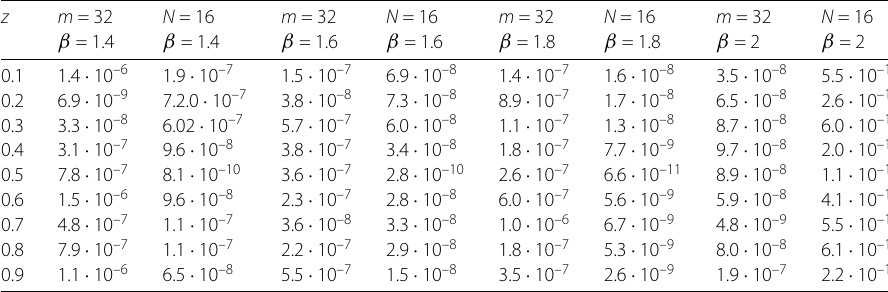
Table 1 Maximum absolute errors E of Example 1